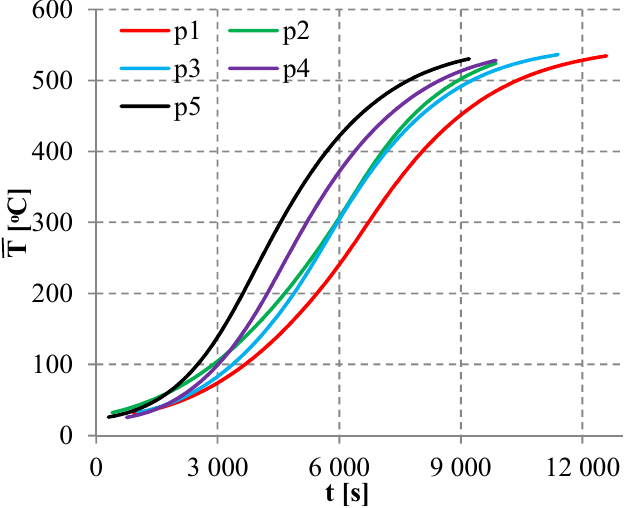
Figure 4. Mean value of temperatures on the cylinder boundary (for planes A1–A4) for processes p1–p5.